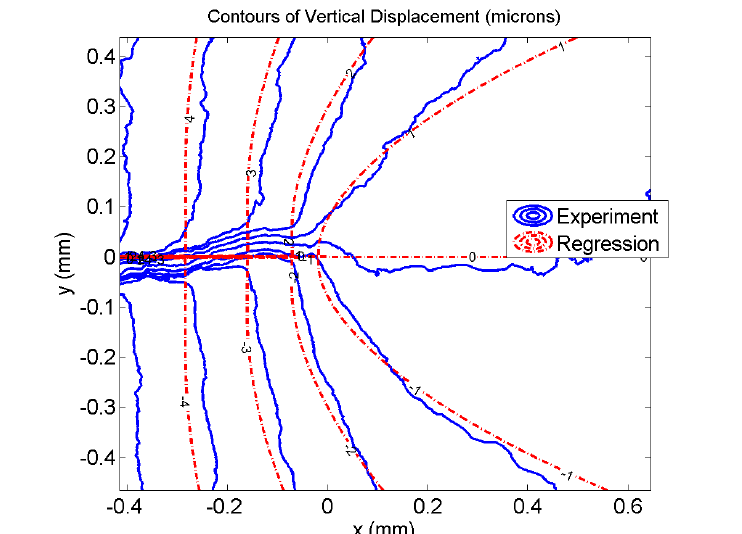
Figure 3: Comparison between the experimental and regresses vertical displacements ( v ) near the crack